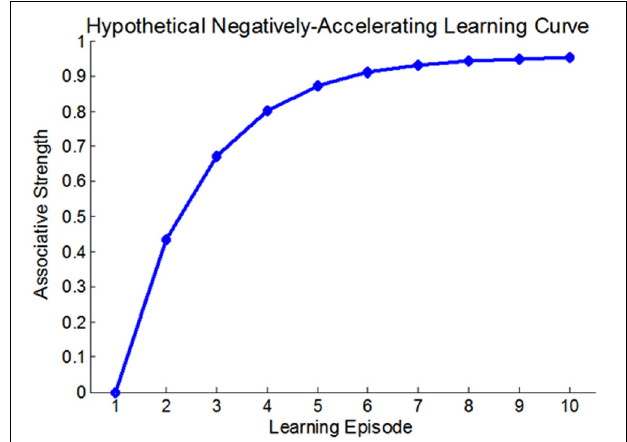
FIGURE 1 | A hypothetical negatively accelerating learning-curve; based on the Rescorla-Wagner associative learning model. In this model, each learning-induced increment in associative strength is a fixed proportion of the difference between the current associative strength and the learning